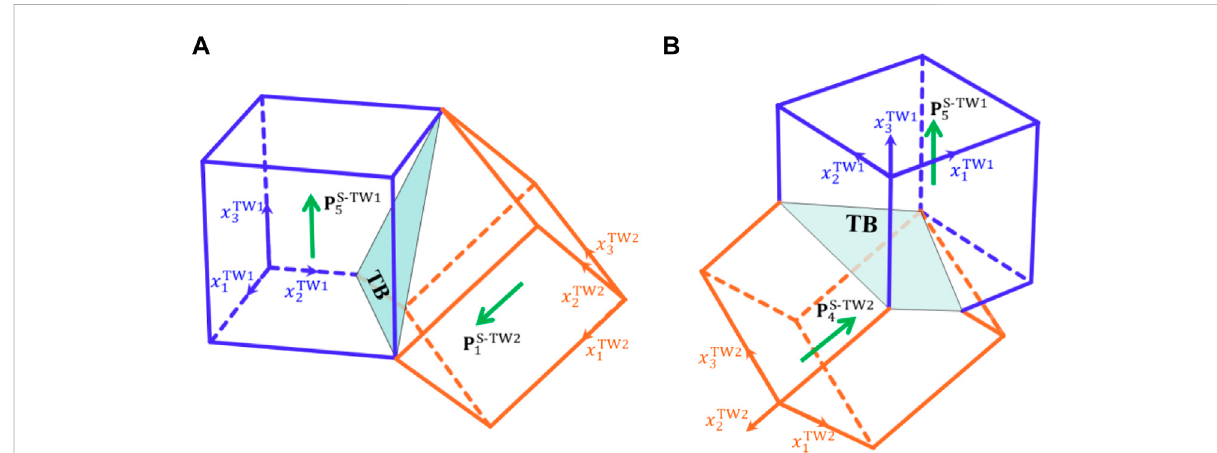
FIGURE 4 Schematics of the possible ( 121 ) -twin and ( 215 ) -twin in tetragonal ferroelectrics. (A) Tetragonal ferroelectric variants ( ε S − TW1 5 , P S − TW1 5 ) with ( ε S − TW2 , P S − TW2 ) ; (B) Tetragonal ferroelectric variants ( ε S − TW1 1 1 coordinate system along cubic crystallographic axes of TW1 and TW2, respectively.